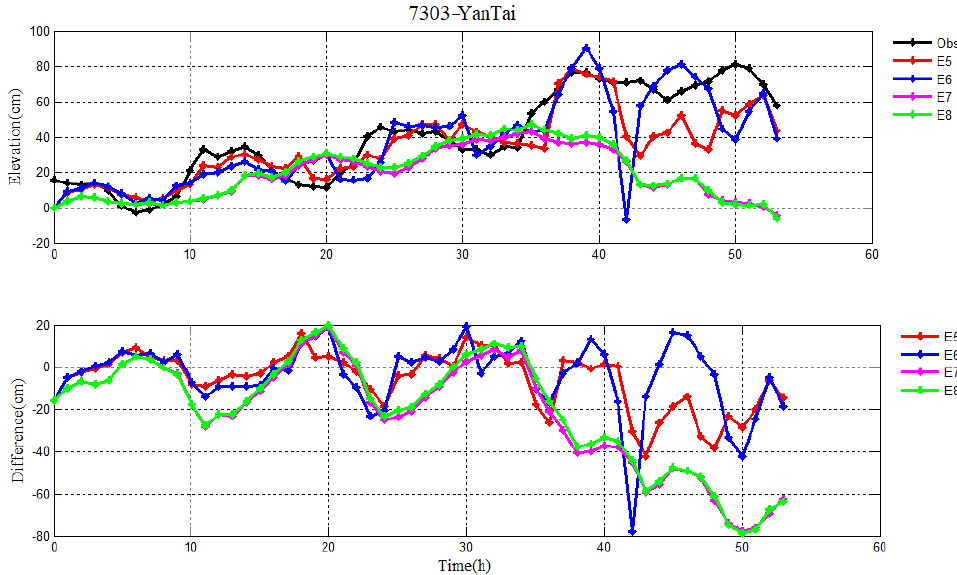
Figure 12. Pure storm surge levels without the astronomical tides in E5 − E8, observation (black line) ( top ), and their differences ( bottom ) during Typhoon 7303 at YanTai station.